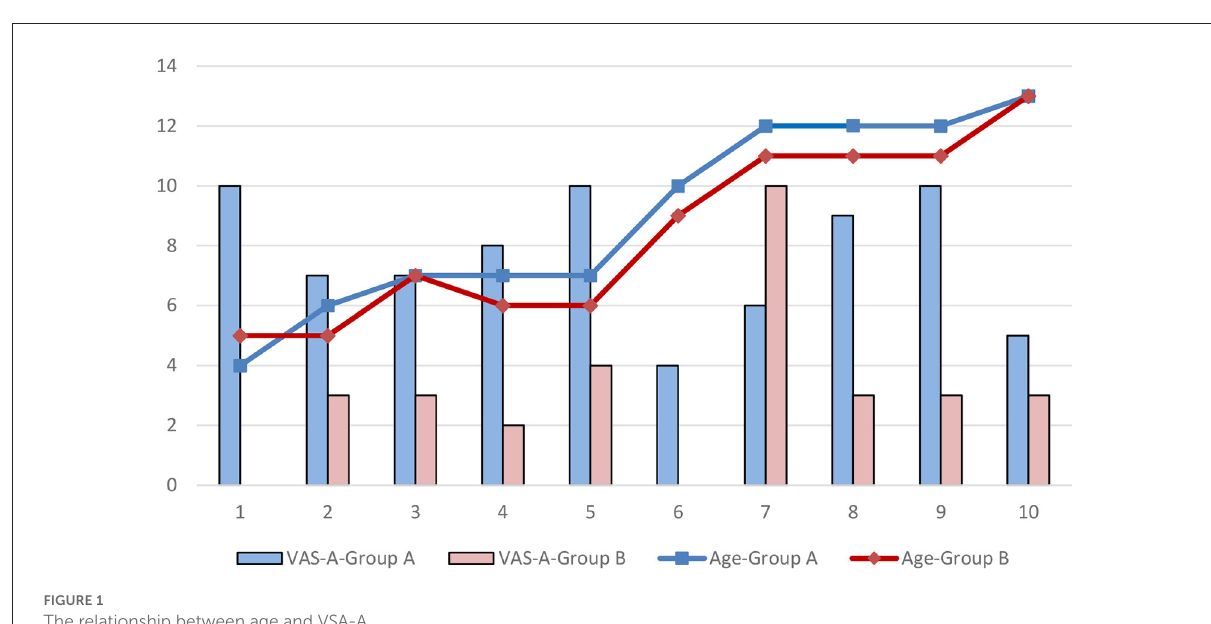
FIGURE1 The relationship between age and